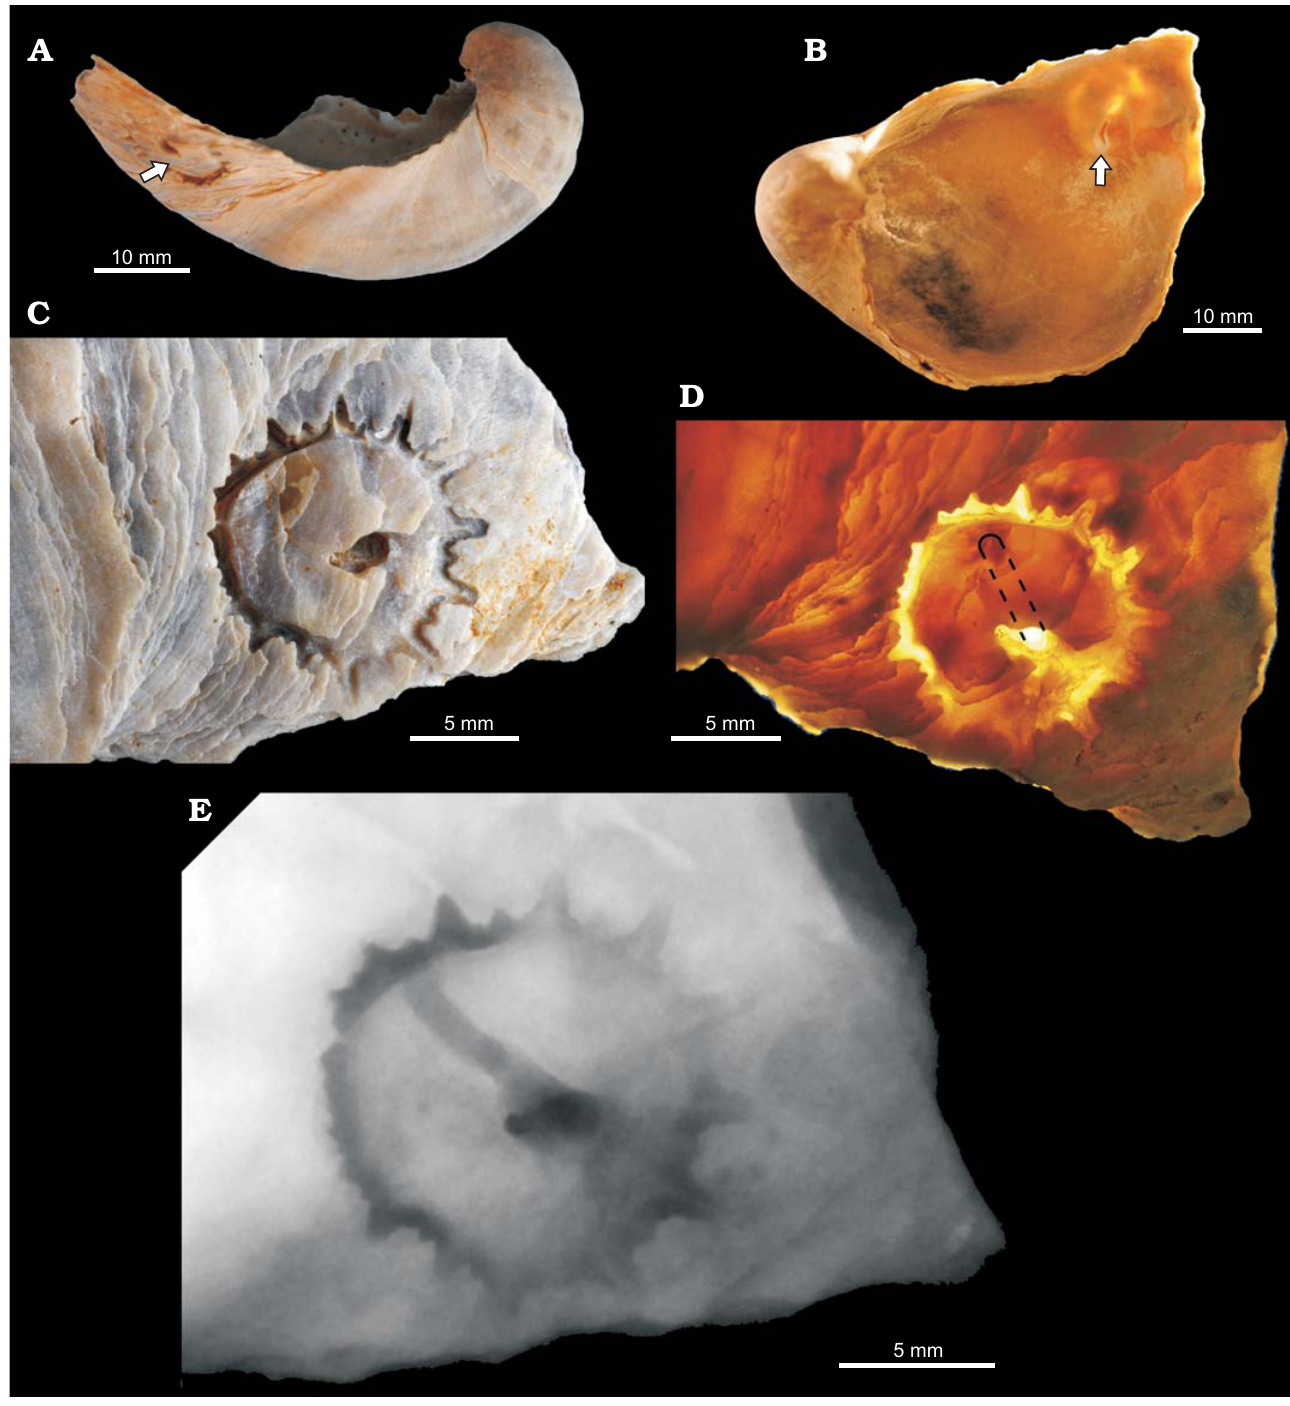
Fig. 5. Parasitic gastropod bioerosion and perforation trace Loxolenichnus stellatocinctus igen. et isp. nov., MHNLM 2015.2.244, holotype, Marnes à Pycnodonte biauricu lata Formation, Upper Cenomanian, Lycée Bellevue earthmoving works, Le Mans, Sarthe Department, France; on LV of Rhynchostreon suborbiculatum (Lamarck, 1801). A . Entire LV shell with the arrow showing the perforation. B . LV (viewed from inside), the arrow shows the opening of the perforation on the inner side of the shell, diascopic illumination. Outer ( C ) and inner ( D ) sides of the shell, close-ups of the perforation, the dashed line delimitates approximately the course of the perforation through the shell, diascopic illumination. E . Positive X-ray print of the opposite direction where they are reduced to small notches is deepest along the side of the rays, so that there is an axial 0.5 mm deep. The transition between the shortest notch and ridge in the axis of each ray. Between the eight main rays on the longest ray is progressive. The longest rays are sharply tri- the ventro-anterior side come in seven accessory rays, 3–5 angular, but their extremity is blunt and rounded. The groove times shorter than the main rays but with an axial ridge too.